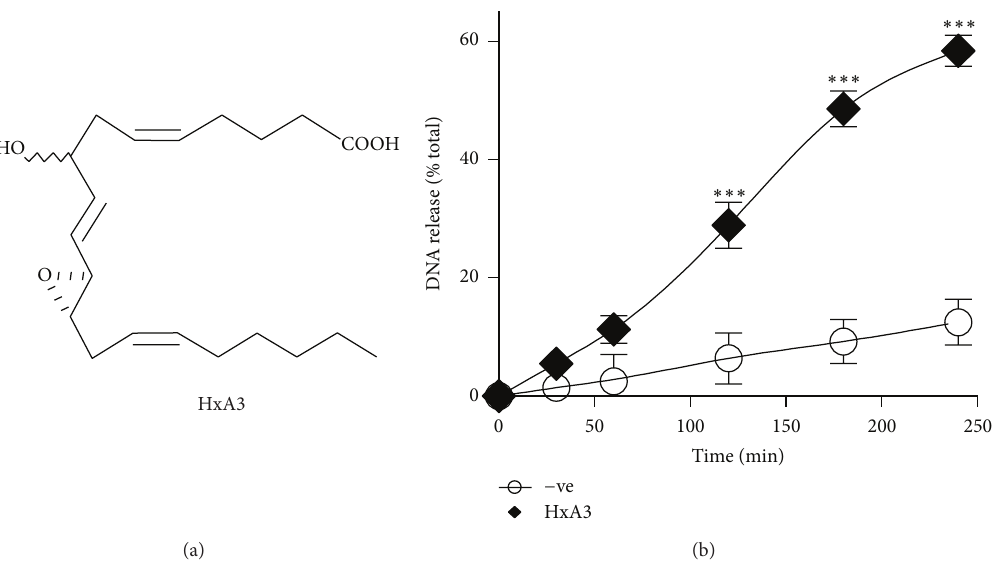
Figure 1: Hepoxilin A3 induces DNA release from human neutrophils. (a) Structure of HxA3. (b) Neutrophils were seeded into 96-well plates in the presence or absence of HxA3, and the extracellular DNA release was monitored using Sytox Green cell impermeable DNA dye. The results show a time-dependent increase in NET release after activation with HxA3 (10 𝜇 g/mL) ( 𝑛 = 4 ). HxA3 was used as the methyl